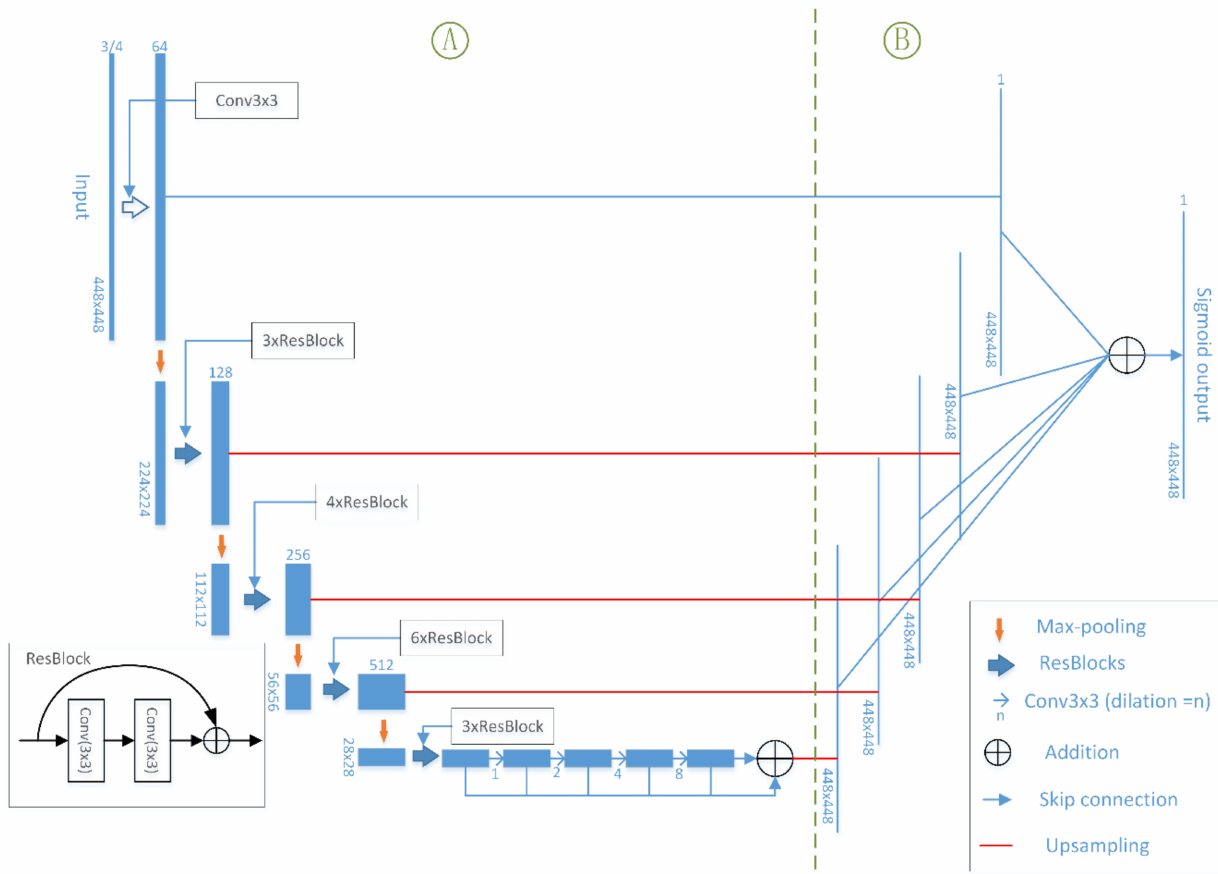
Figure 2. Our network for detecting the building edge, which is modified from D-LinkNet. D-LinkNet is composed of an encoder, center part and decoder. Part A in our network retains the original encoder and center part from D-LinkNet for effectively extracting the multi-scale features in the image. Part B uses multi-scale fusion to replace the decoder, has a wide receptive field and keeps the ability of spatial detail representation. For each stage of the encoder, we use the transposed convolution layer for upsampling and restoring the resolution of the feature image to 448 * 448. Then, the network calculates the loss function of each stage to obtain more accurate edge location